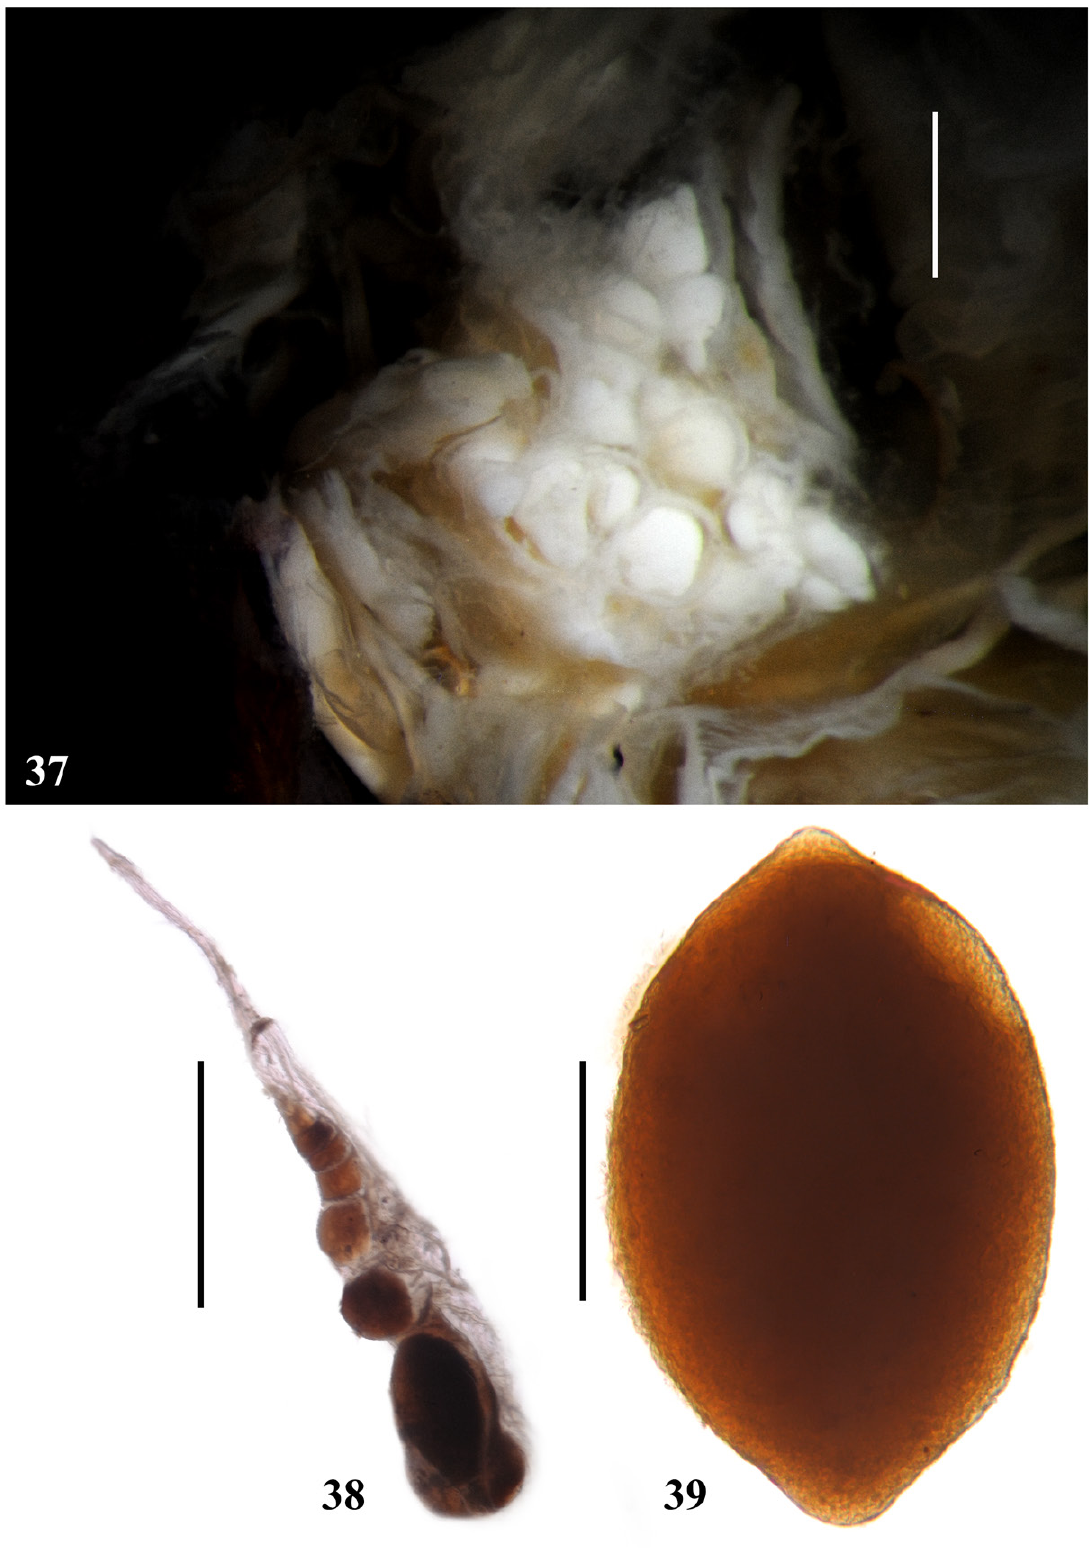
Figs 37–39. Ovary, ovarioles and egg of Oryctopterus varuna sp. nov. Paratype, ♀ (NBAIR). 37 . Ovary. 38 . Ovariole. 39 . Egg. Scale bars: 37–38 = 1 mm; 39 = 0.1